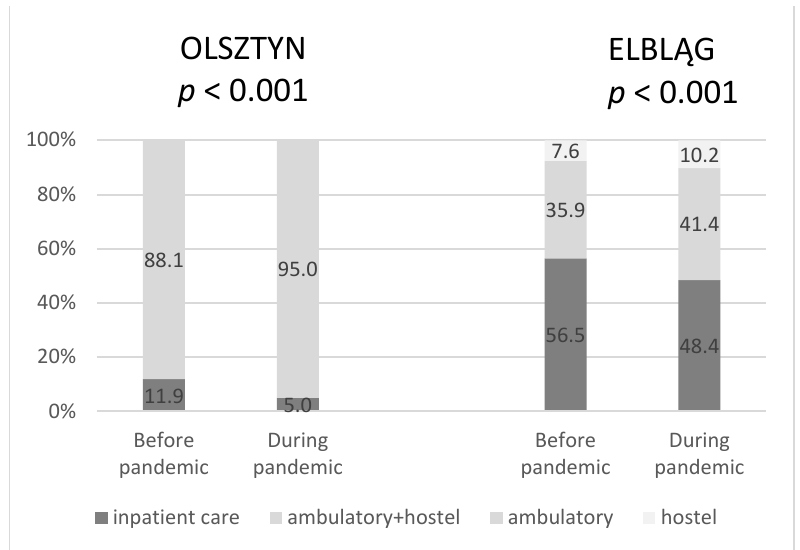
Figure 3. The percentage of procedures due to different types of a patient’s care before and during the pandemic in Olsztyn and Elbląg.